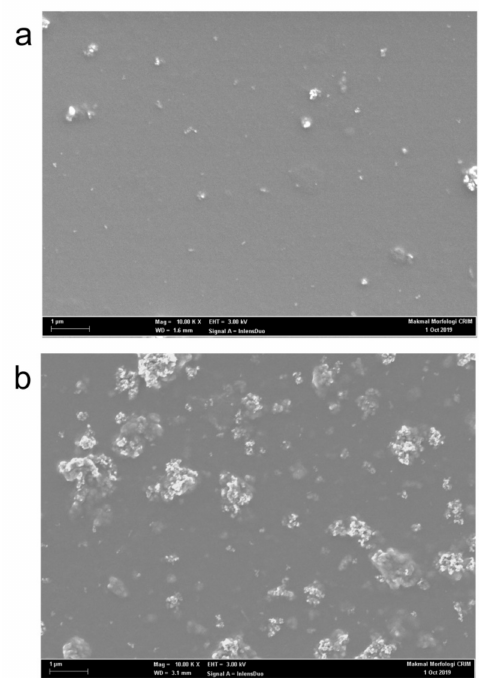
Figure 7. FESEM images of PFO / 0.5 wt.% F8BT / 0.3 wt.% MEH-PPV / TiO 2 nanocomposite